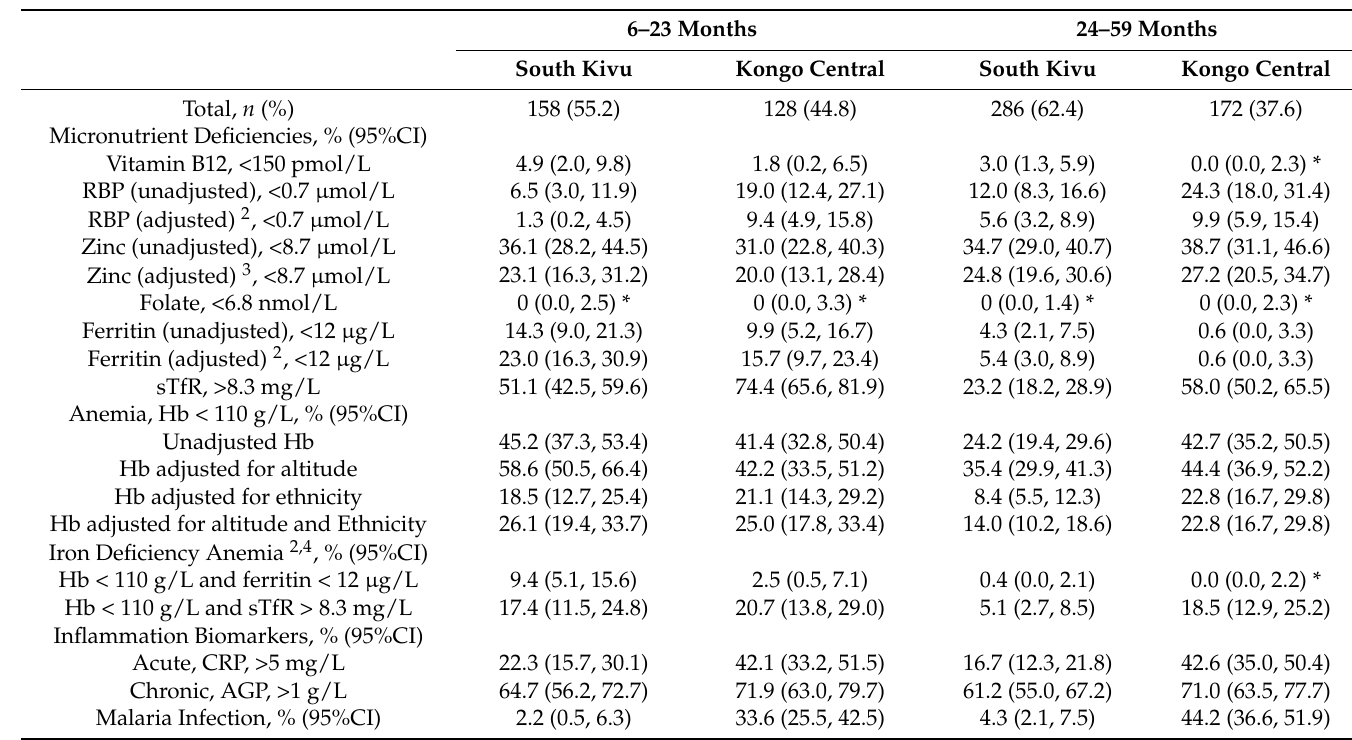
Table 5. Prevalence of micronutrient deficiencies, anemia, iron deficiency, inflammation and malaria among children 6–23 and 24–59 months ( n = 676–744) by province 1